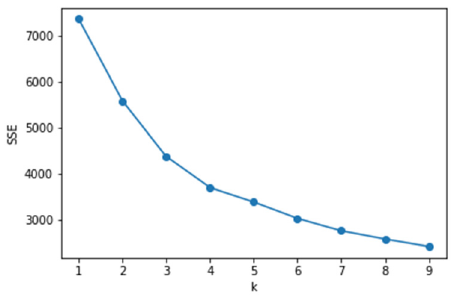
Figure 13. Intra-cluster error variance SSE.